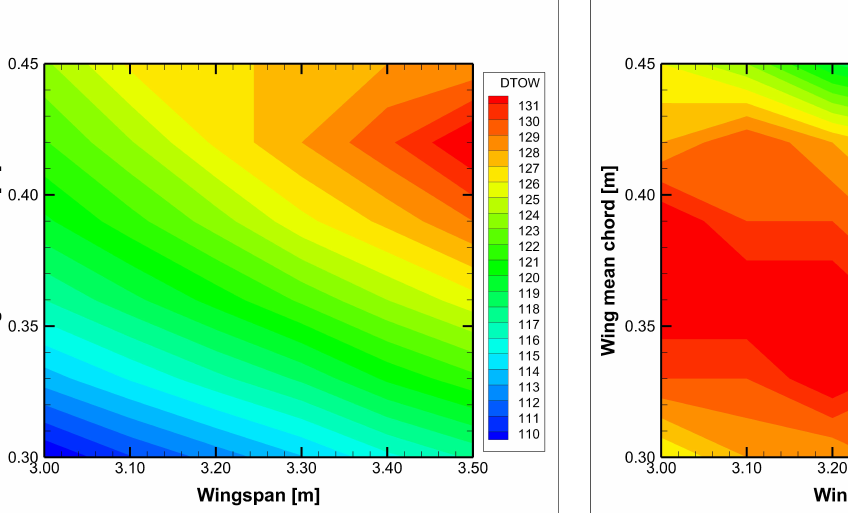
Figure 11: Design take-off weight [N] as a function of wingspan and wing mean chord.